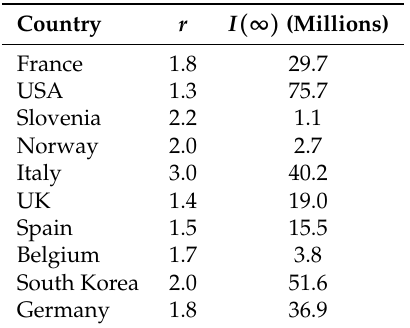
Table 2. Growth parameter r for the logistic map, empirically calculated for the same countries during the first days of the spread of the COVID-19 epidemics, and equilibrium value for the infected people if no countermeasures were applied. Country r I ( ∞ ) (Millions)